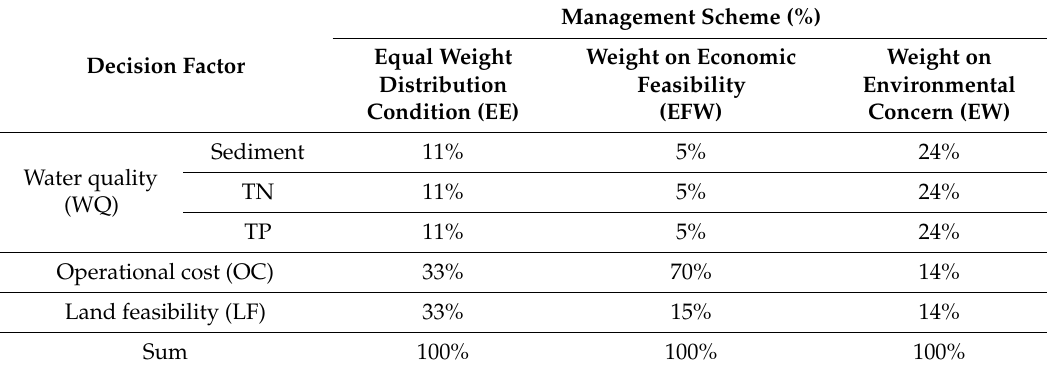
Table 3. Weighting vectors for di ff erent management schemes (EE, EFW, and EW) with decision factors (WQ, OC,